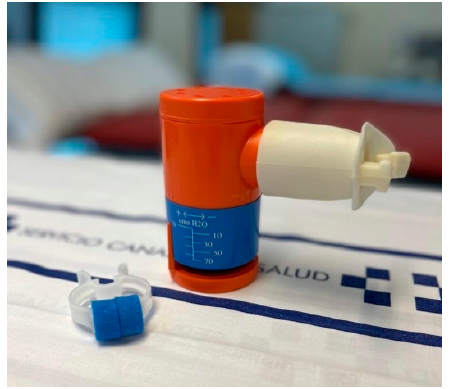
Figure 3. Inspiratory valve used in the training programme.